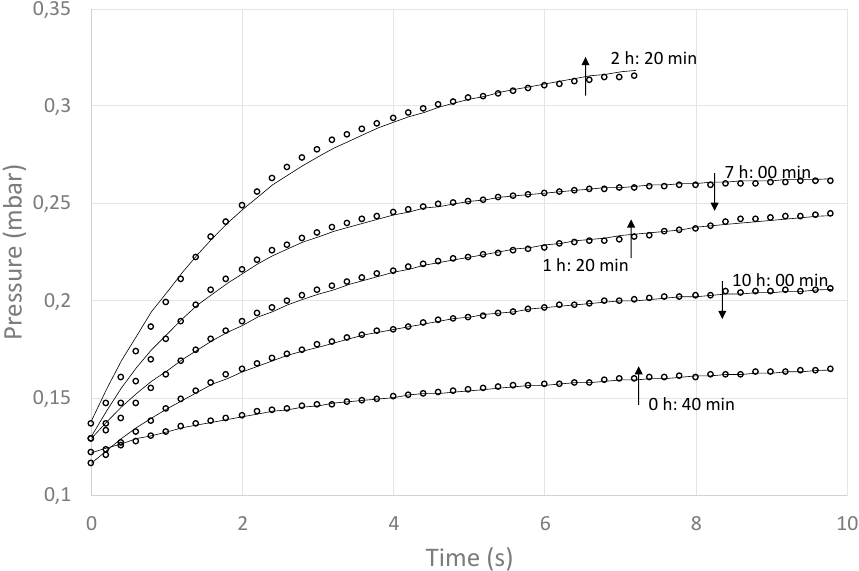
Figure 6. Fit of MTM equation to experimental pressure rise profiles for progressive times along the freeze-drying process of whole nontreated blueberries.